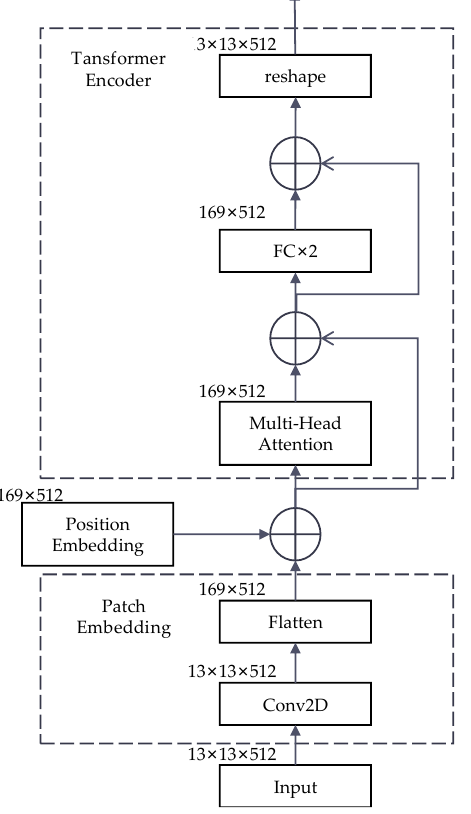
Figure 9. The structure of the Vision Transformer.